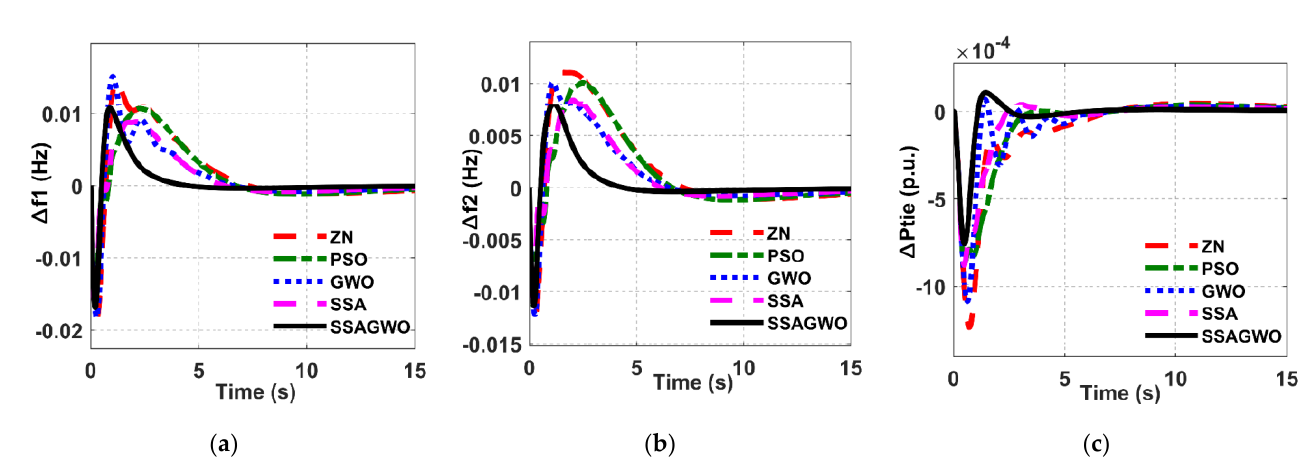
Figure 8. The frequency deviation responses of the optimization techniques and conventional Ziegler– Nichols method for tuning PID controller parameters for case I: ( a ) The frequency deviation of area 1; ( b ) The frequency deviation of area 2; ( c ) The power deviation of the tie line. Table 4. Frequency and power deviation in the tie-line power of case I.